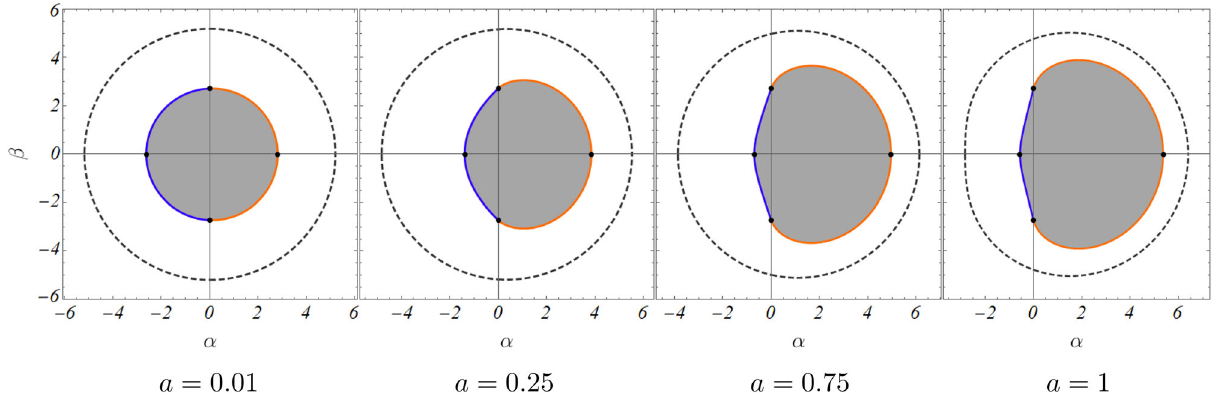
) , and observer inclination angle θ = 45 ◦ . The same conventions are used as in 0 r In a similar way, the rightmost edge is located at the intersec- tion of the curve representing the outer family of spherical orbits with the axis β = 0. It corresponds to a radial distance solution to the